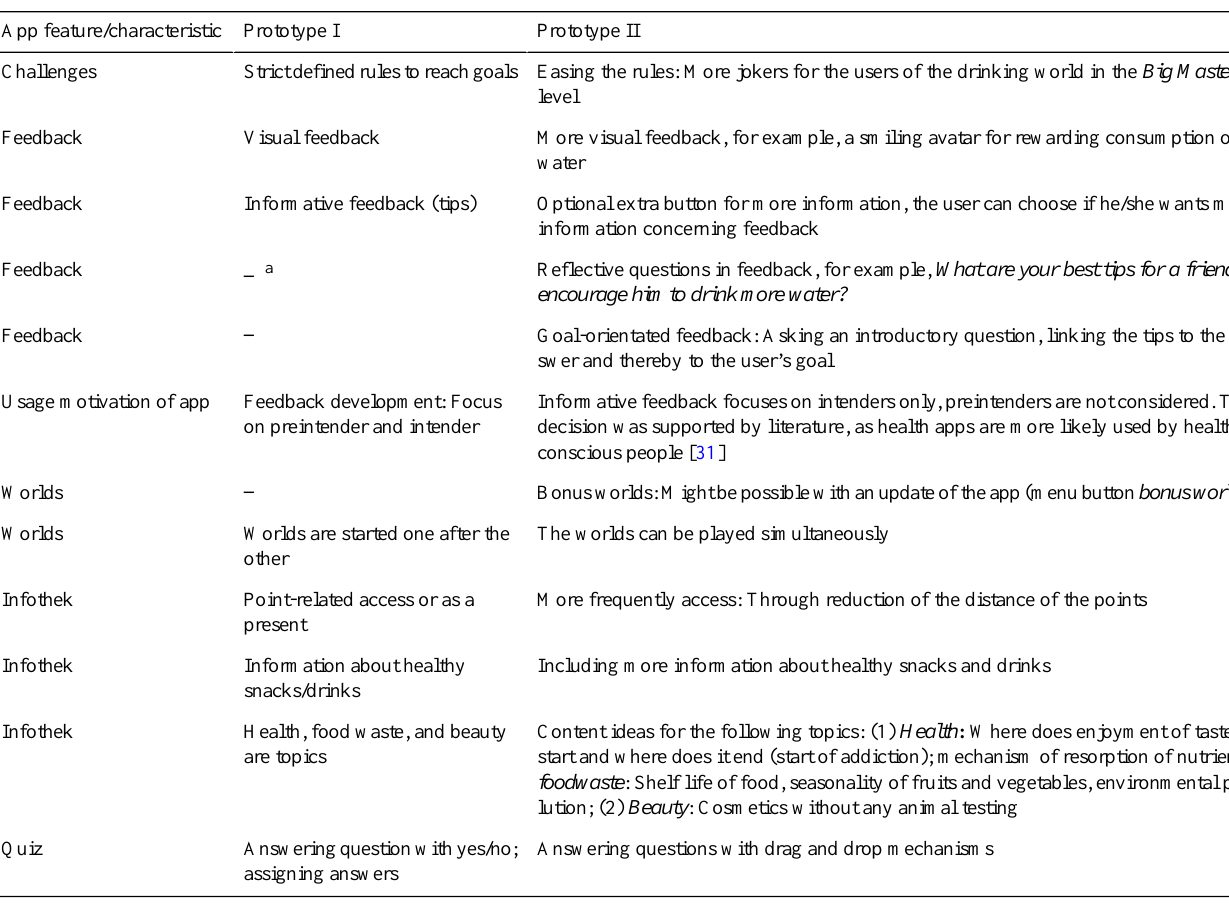
Table 4. Concept changes after expert evaluation.